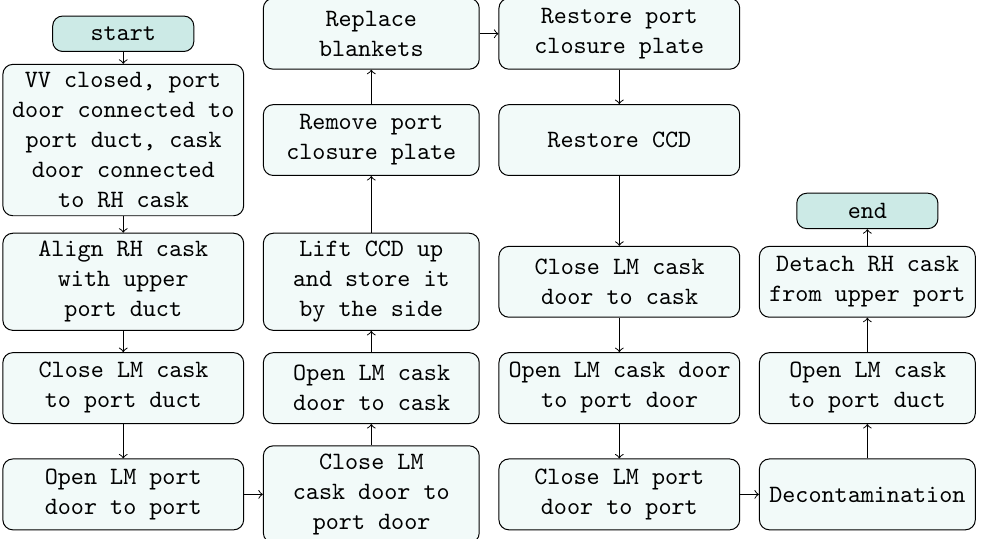
Figure 11. The flow chart of operation sequences for maintenance of